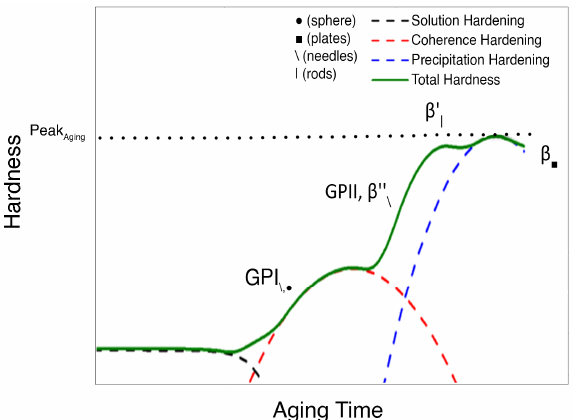
Figure 9. Theoretical representation of the hardness evolution as a function of the artificial aging time and the associated physical mechanisms of samples A, B, and C.